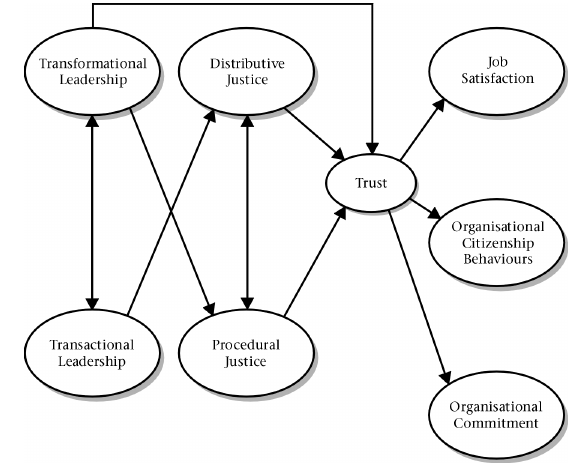
Figure 1: Theoretical model of the relationship